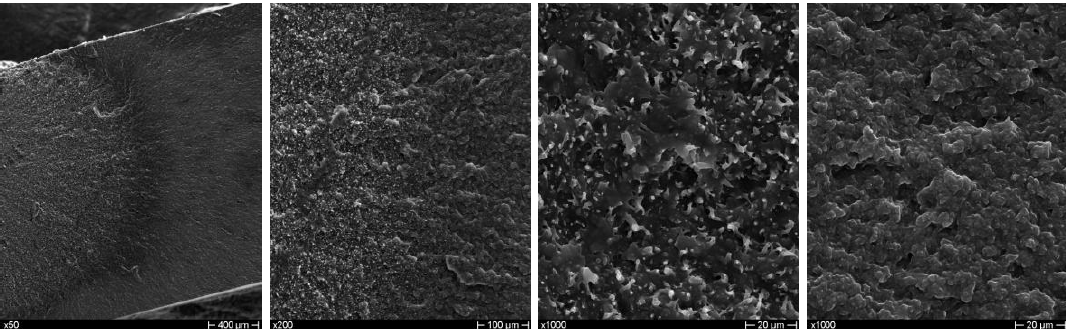
Figure 6. SEM micrographs of the polymer blend compatibilized with MLO at different